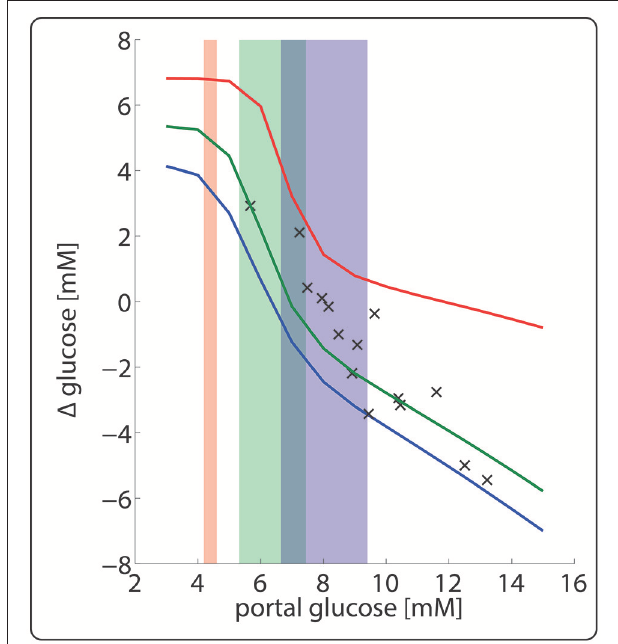
FIGURE 8 | Hepatic porto-venous glucose difference (AVGD) for the well-fed and fasted nutritional state. The daily variations of plasma glucose in the fasted, fed and well-fed state are indicated by the red-, green- and blue-shaded areas. The solid lines represent the AVGD if in the fasted state (red), fed state (green) and the well-fed state (blue). Crosses depict experimentally measured AVGD (Huang and Veech, 1988).